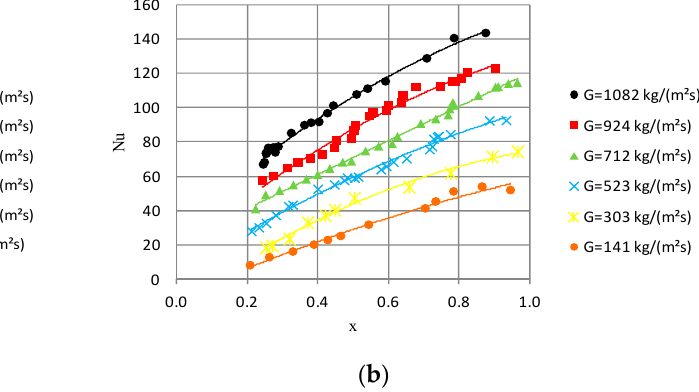
Figure 6. Dependence of Nusselt number on average vapor quality Nu = f(x a ) for few mass flux densities G during HFE 7000 condensation in minichannels with internal diameter: ( a ) d i = 1.2 mm, inlet T s = 39 °C; ( b ) d i = 2.5 mm, inlet T s = 42 °C.